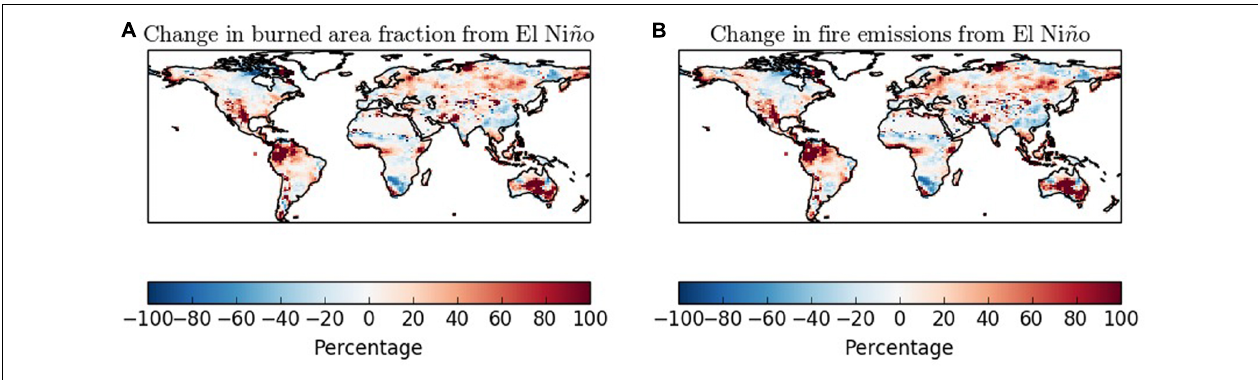
FIGURE 4 | Change in burned fraction (A) and fire emissions (B) due to El Niño, July 2015–June 2016 simulated by